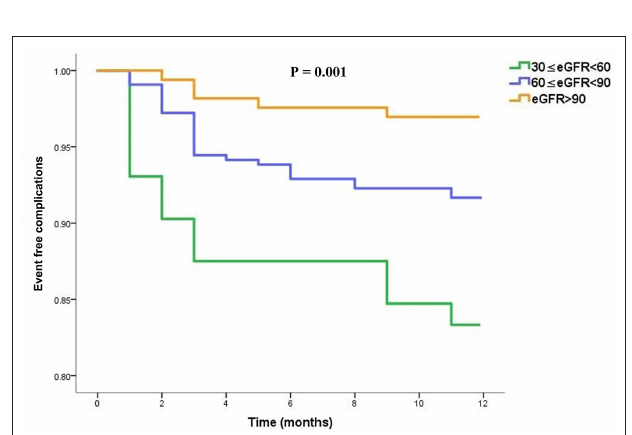
FIGURE 4 | Event-free complications curves in dabigatran treated patients, stratified into three subgroups (moderate, mild and normal) according to the eGFR category.